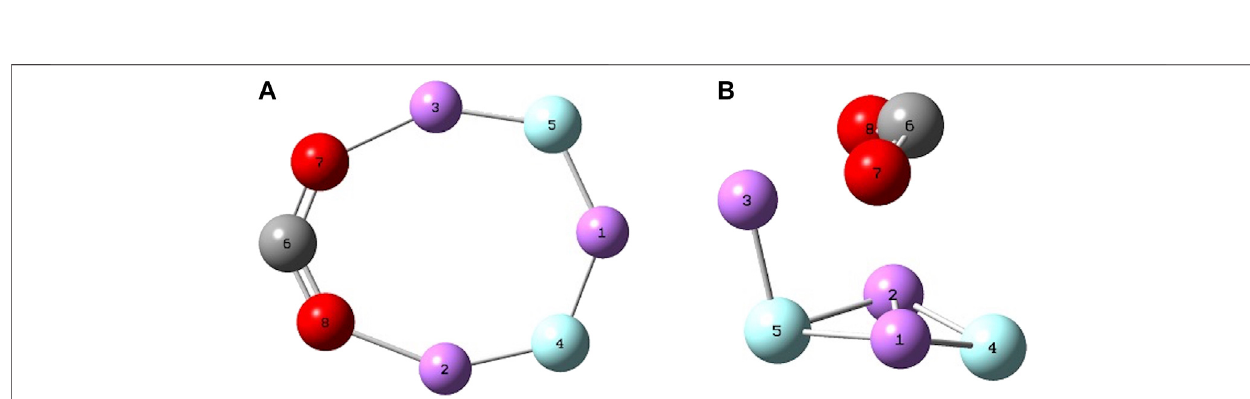
Frontiers in Chemistry |